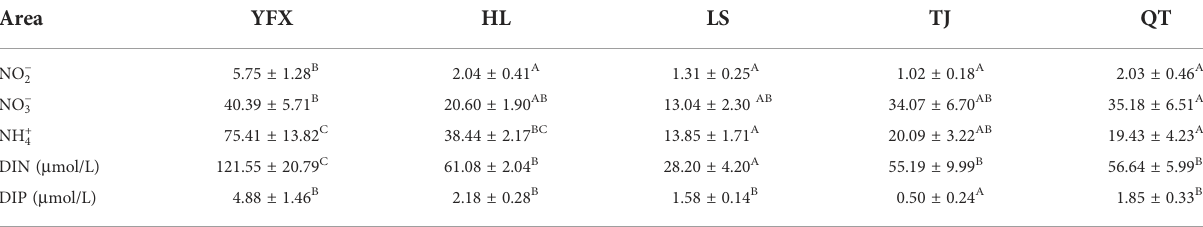
TABLE 1 Seawater nutrients parameters in HI, LS, TJ, YFX, and QT (Mean ± SE). The different capital letters indicate signi fi cant differences among the fi ve seagrass meadows. Identical superscripts indicate non-signi fi cantly different means. Area YFX